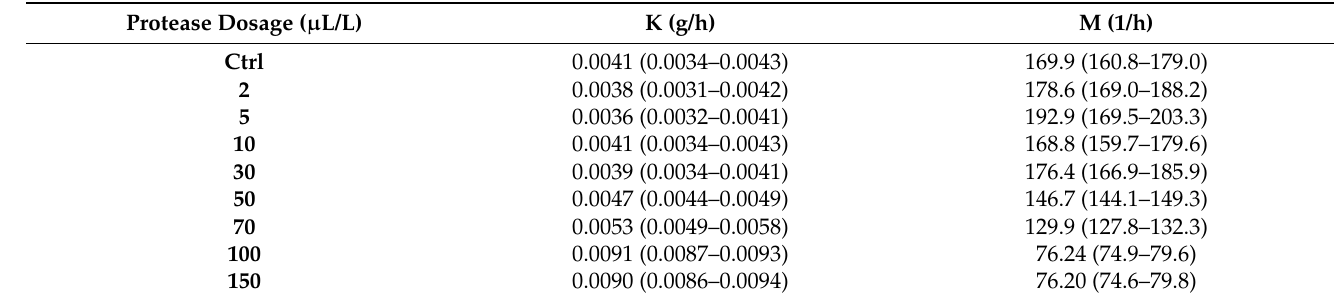
Table 3. Parameters obtained by fitting the altered Gompertz equation to the experimental data of weight loss. K: alcoholic fermentation rate; M: half-time of weight